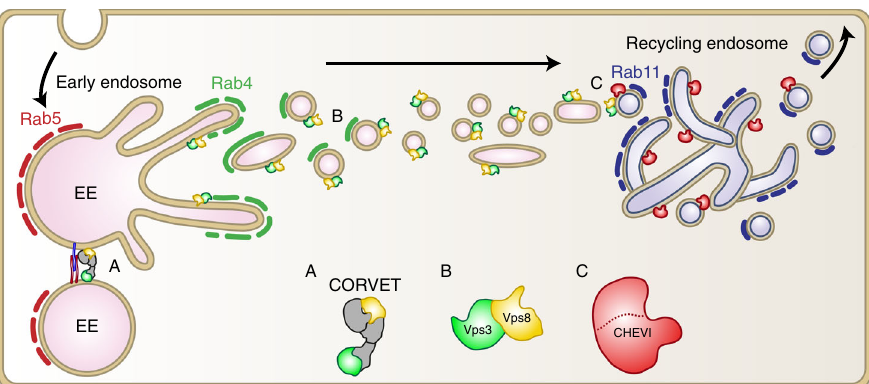
Fig. 6 Model of the proposed function of Vps3 and Vps8 in endosomal recycling. The CORVET complex mediates the fusion between Rab5-positive EEs (A). Vps3 and Vps8 localise to Rab4-positive vesicles emerging from EEs (B). The Vps3/8-positive recycling vesicles deliver integrins to Rab11- and CHEVI-positive